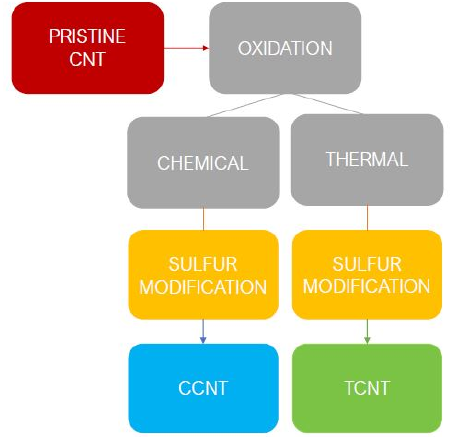
Figure 3. Scheme of the functionalization process of CNTs.